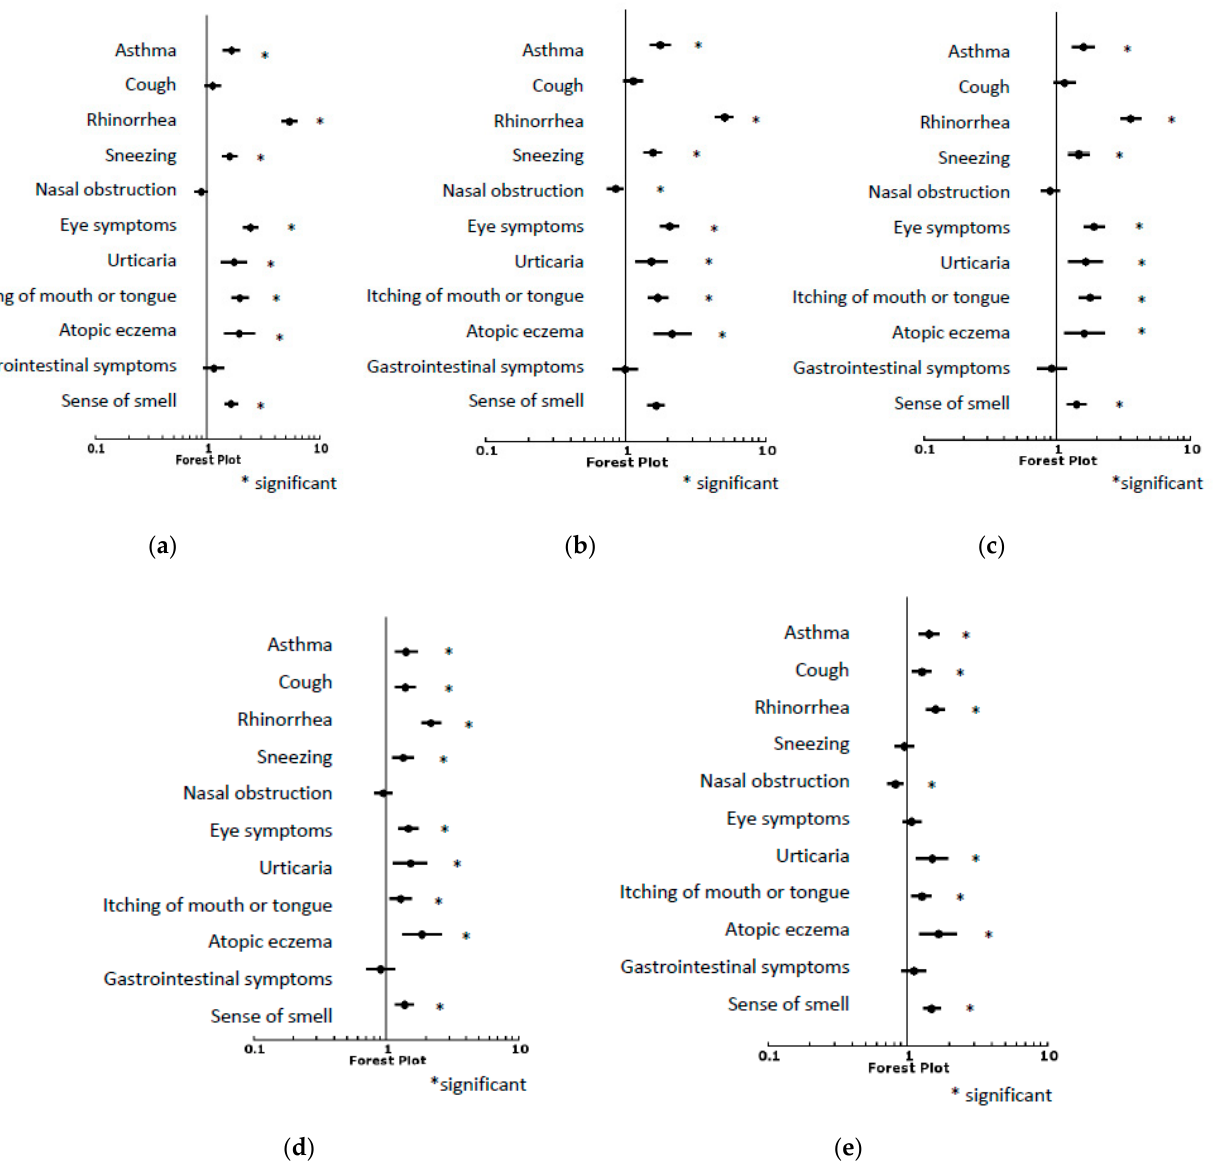
Figure 5. ( a – e ) Correlation of symptoms. ( a ) Symptoms associated with spring bloomers; ( b ) Symptoms associated with summer bloomers; ( c ) Symptoms associated with autumn bloomers; ( d ) Symptoms associated with mites; ( e ) Symptoms associated with mold.